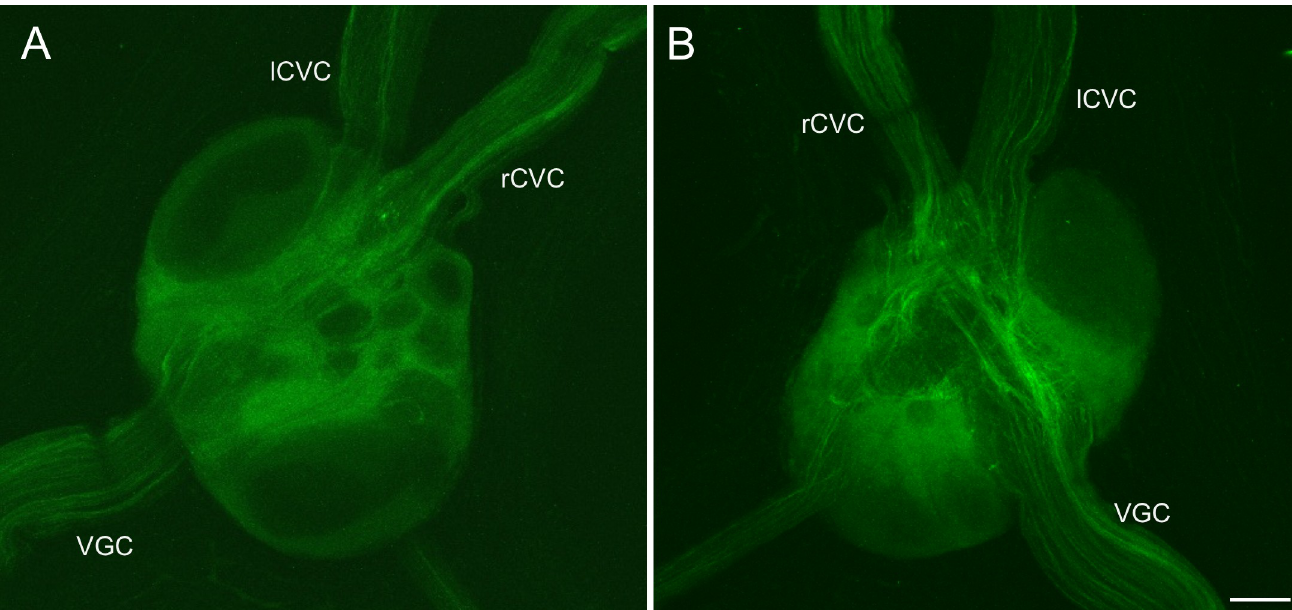
Fig 6. THli in the visceral ganglion. (A) Dorsal view of the visceral ganglion. No immunoreactive somata were observed. (B) Ventral view of the visceral ganglion. THli fibers with an anteroposterior orientation were found passing through the ventral surface of the ganglion, colocated between one of two cerebrovisceral connectives (lCVC, rCVC) and the visceralgenital connective (VGC). Calibration bar = 80 μ m, applies to A and B.